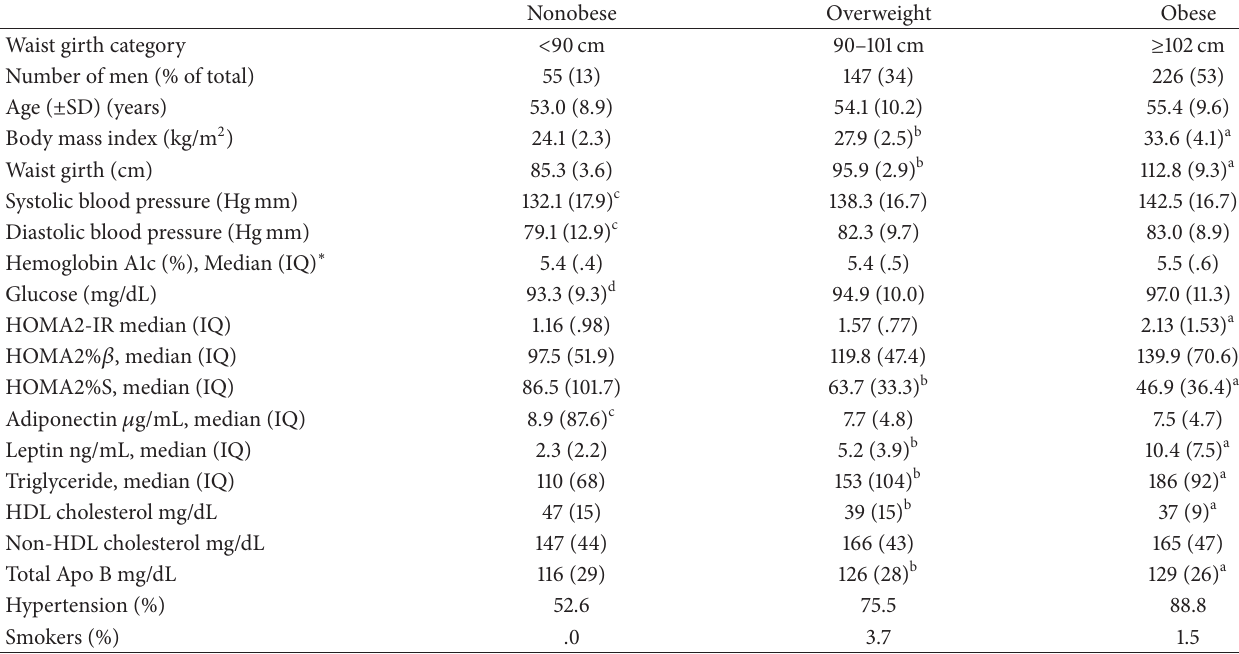
Table 1: Subject demography and baseline